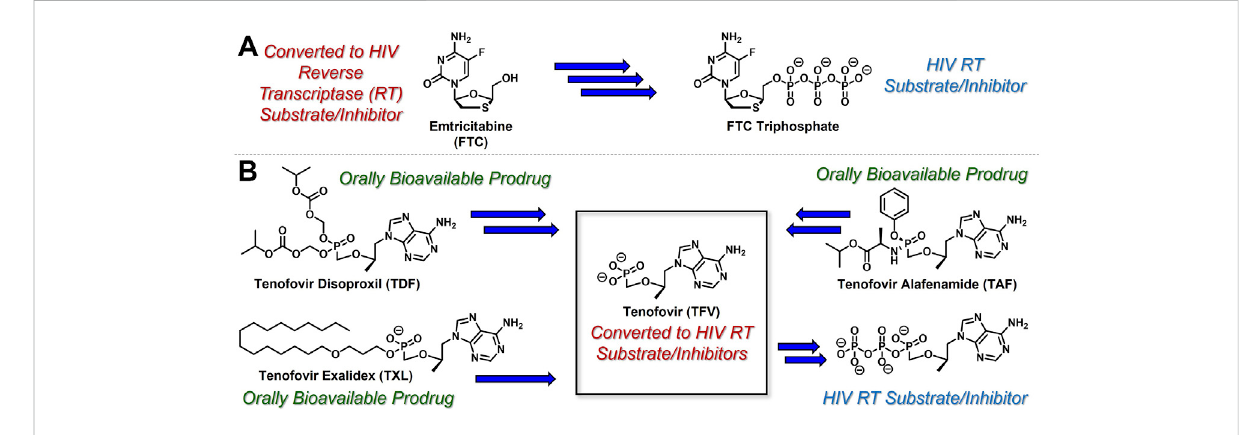
FIGURE 6 Antiretroviral (A) nucleoside and (B) nucleotide therapeutics developed to treat HIV